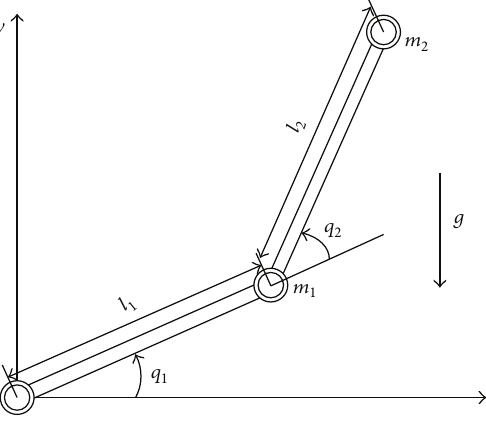
Figure 1: Diagram of a two-link robot